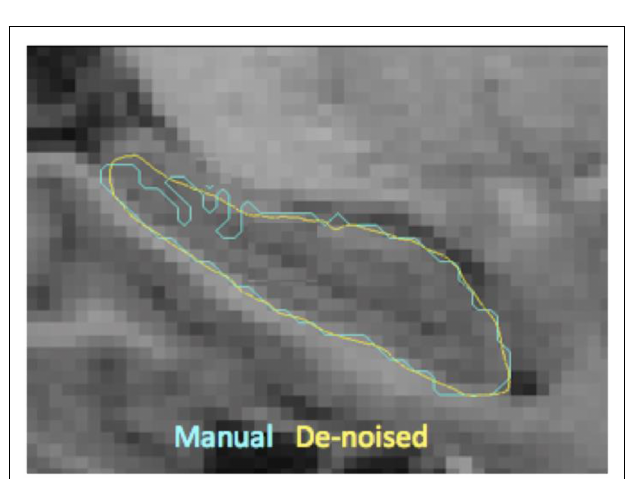
FIGURE 1 | Distribution of normalized volumes of hippocampi and lateral ventricles forAD, FTD, and NC groups .The title of the plot identifies the structure for which the volumes are plotted (e.g., LH for left hippocampus, RH for right hippocampus, LV for left ventricle, and RV for right ventricle). In plots 1 and 2, the distributions of volumes for FTD and AD are slightly below the NC group reflecting overall hippocampal atrophy. However, the distributions of